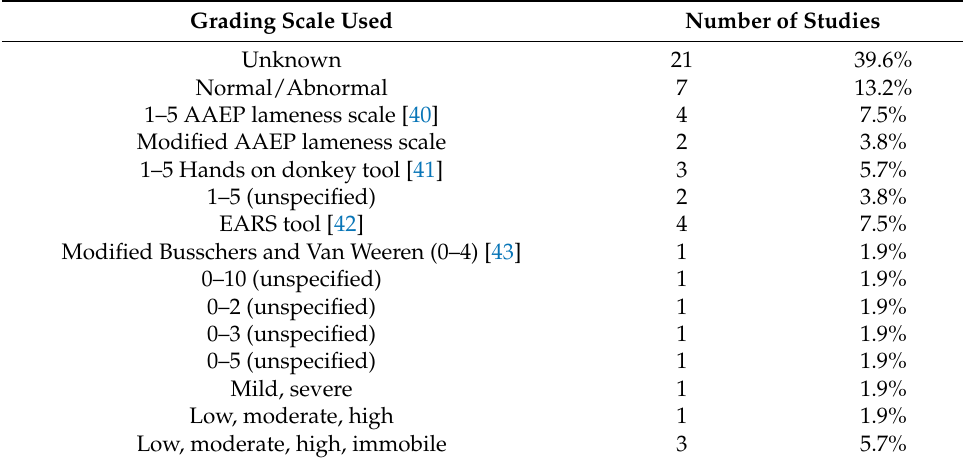
Table 1. Grading scales of lameness or gait abnormality used for the assessment of outcome severity in a systematic review of studies ( n = 53) investigating working equid lameness in low- and middle- income countries, 2003 to